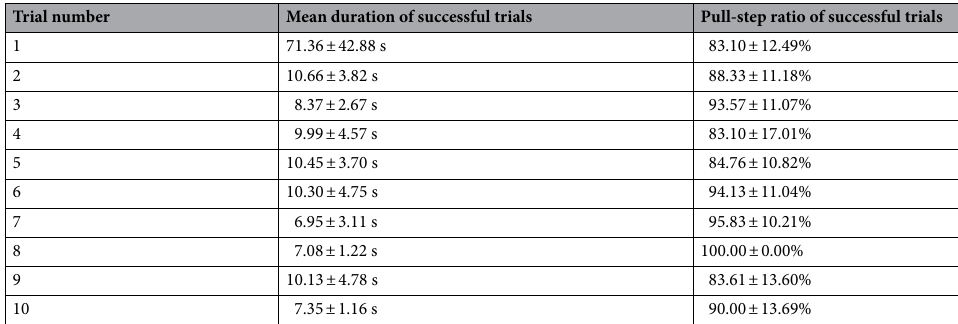
Table 3. The first column shows the average duration across all individuals’ successful trials in Experiment 2, measured as the time taken from touching the string for the first time to holding the black token. Unsuccessful trials where individuals failed to retrieve the rewarding token are not included. The second column contains the pull-step ratios across individuals their successful trials, calculated as the percentage of correct pulls followed by steps (or other string attachments) over all attempts to pull the vertical